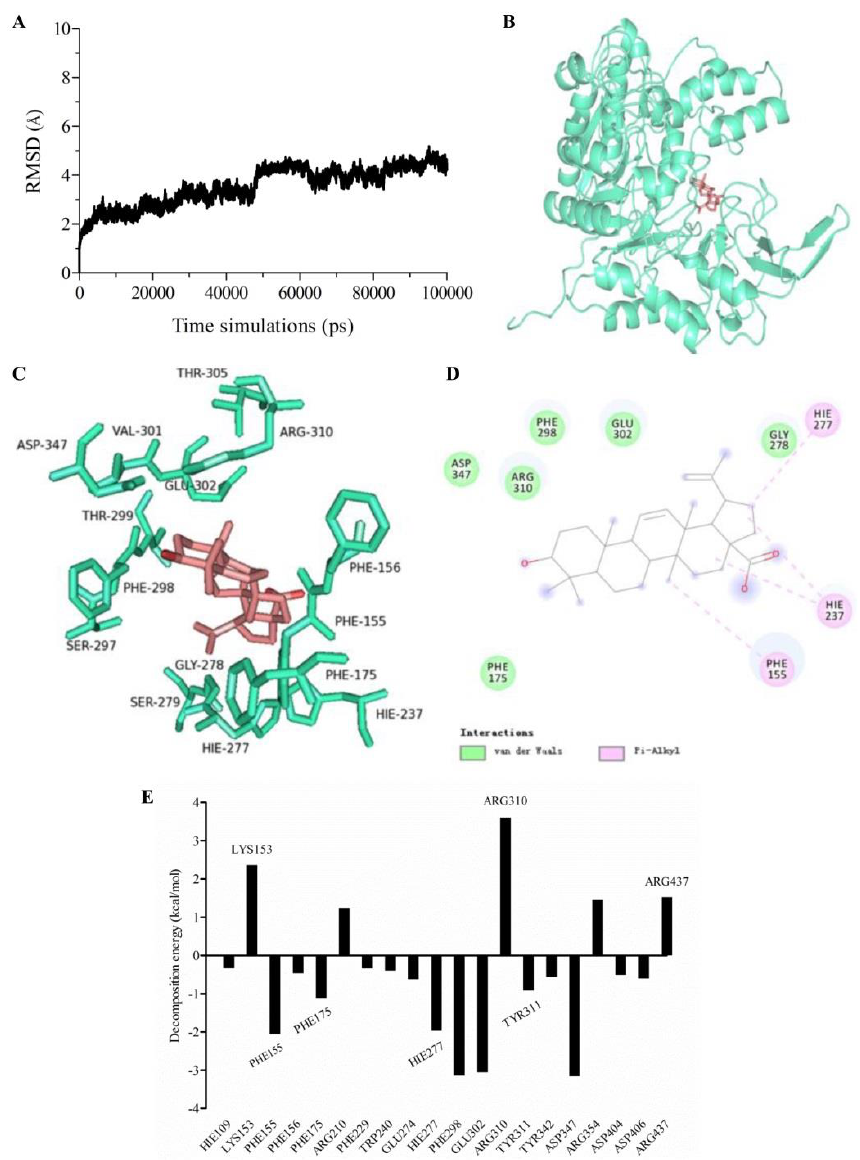
Figure 4. Molecular dynamics simulation. ( A ) Time dependence of root mean square deviation (RMSD) of the backbone of the protein in the complex; ( B ) Conformation of the binding of BA to α -glucosidase; ( C ) Interactions of BA to key residues of α -glucosidase; ( D ) 2D scheme of interactions of BA to key residues of α -glucosidase. Green and pink AA residues represent van der Waals interaction and Pi-alkyl interaction, respectively. ( E ) Decomposition of binding free energy of each residue for α -glucosidase.